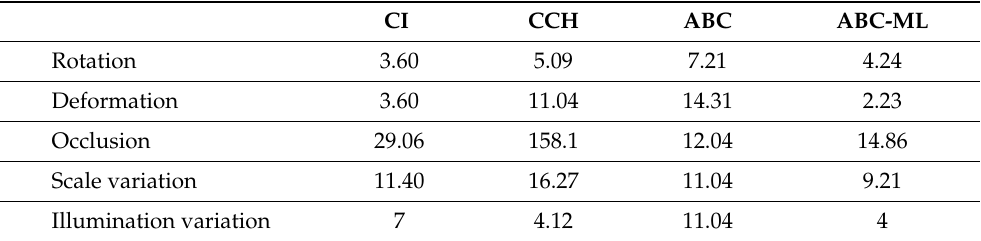
Table 2. Location error in color histogram-based methods.